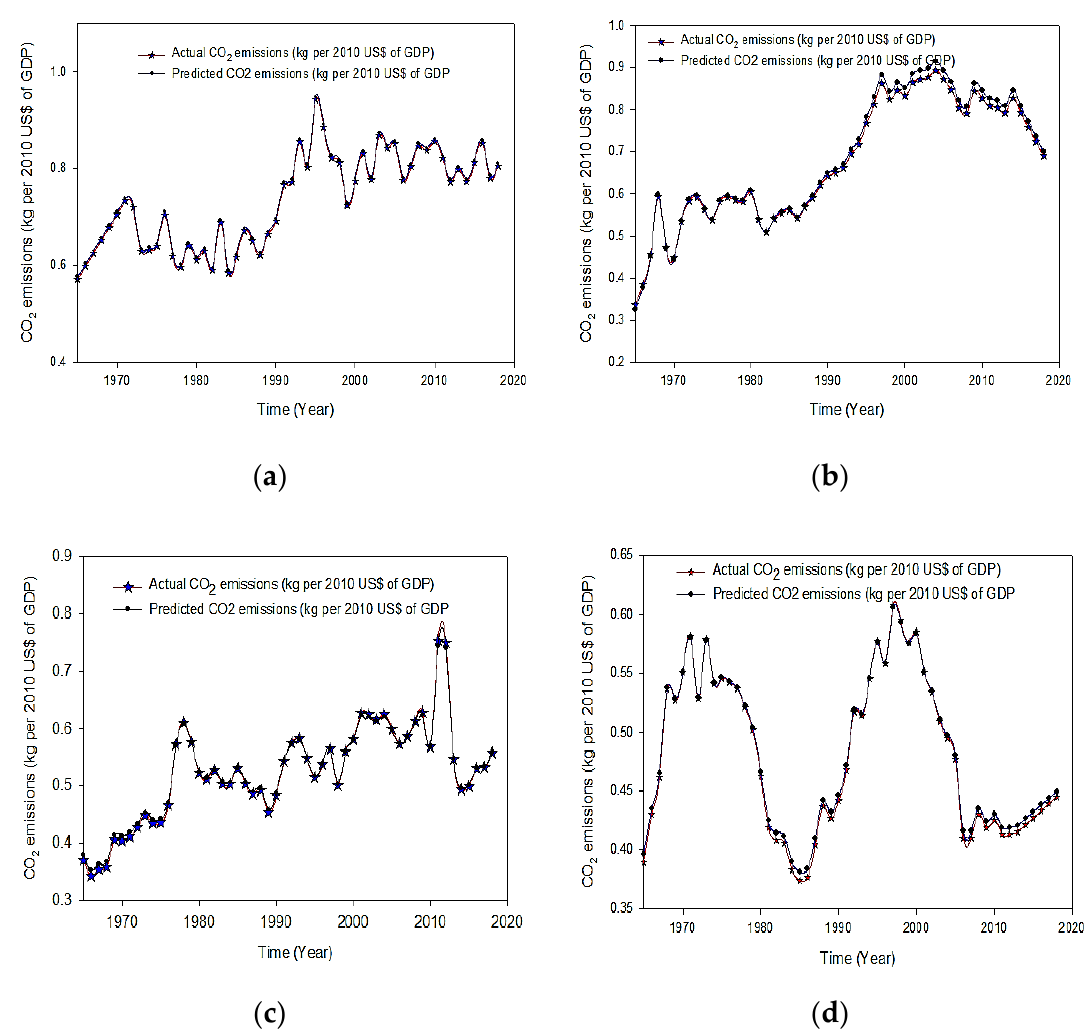
Figure 5. Dispersion plot showing the actual and predicted CO 2 emissions from ( a ) Malaysia, ( b ) Thailand, ( c ) Indonesia, ( d ) Philippines.